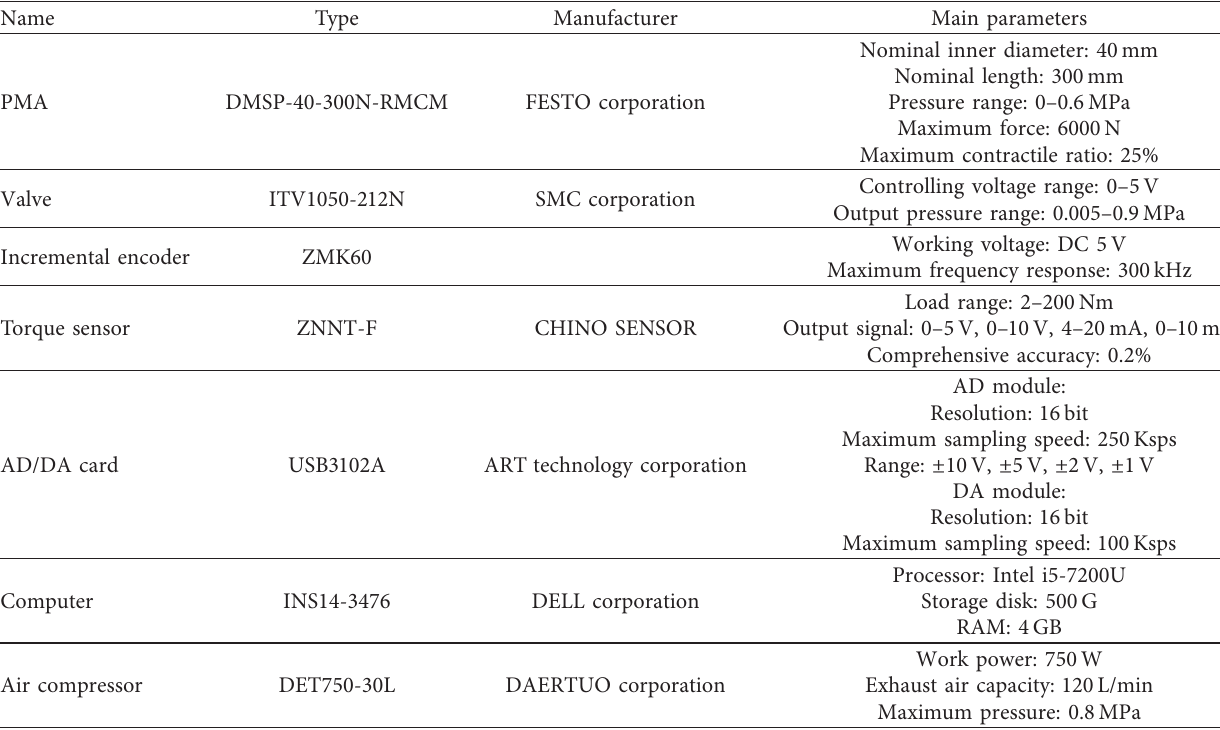
Table 1: Components of the PMA-driven rehabilitation ankle